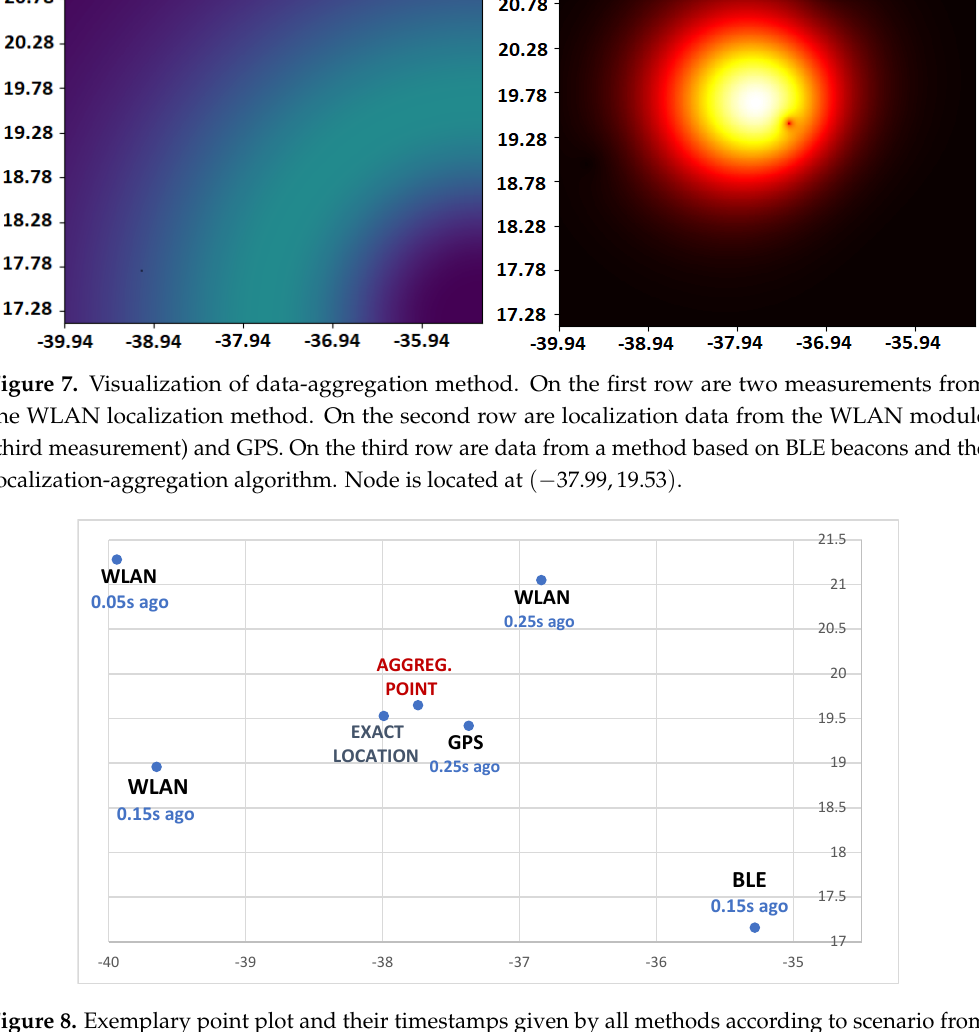
Figure 8. Exemplary point plot and their timestamps given by all methods according to scenario from Figure